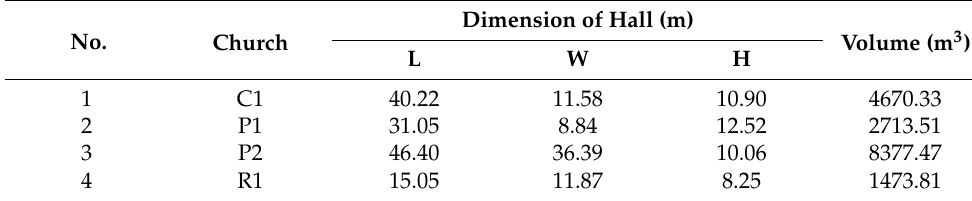
Table 2. Main dimensions of the churches in this study.